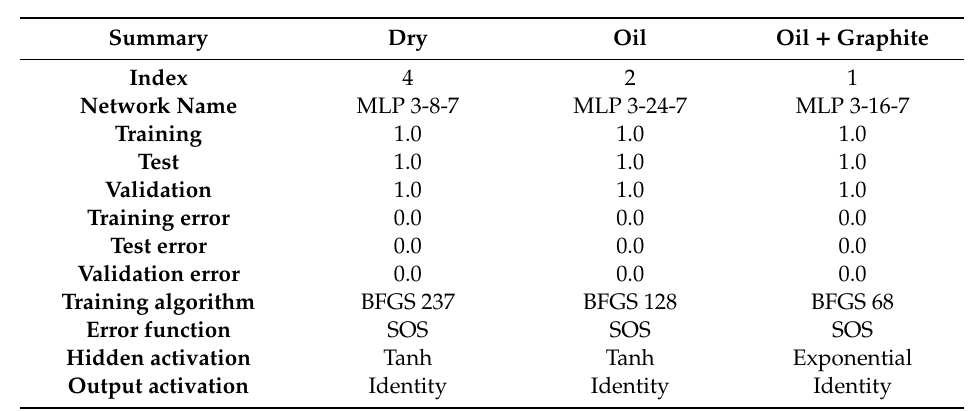
Table 12. Summary of active